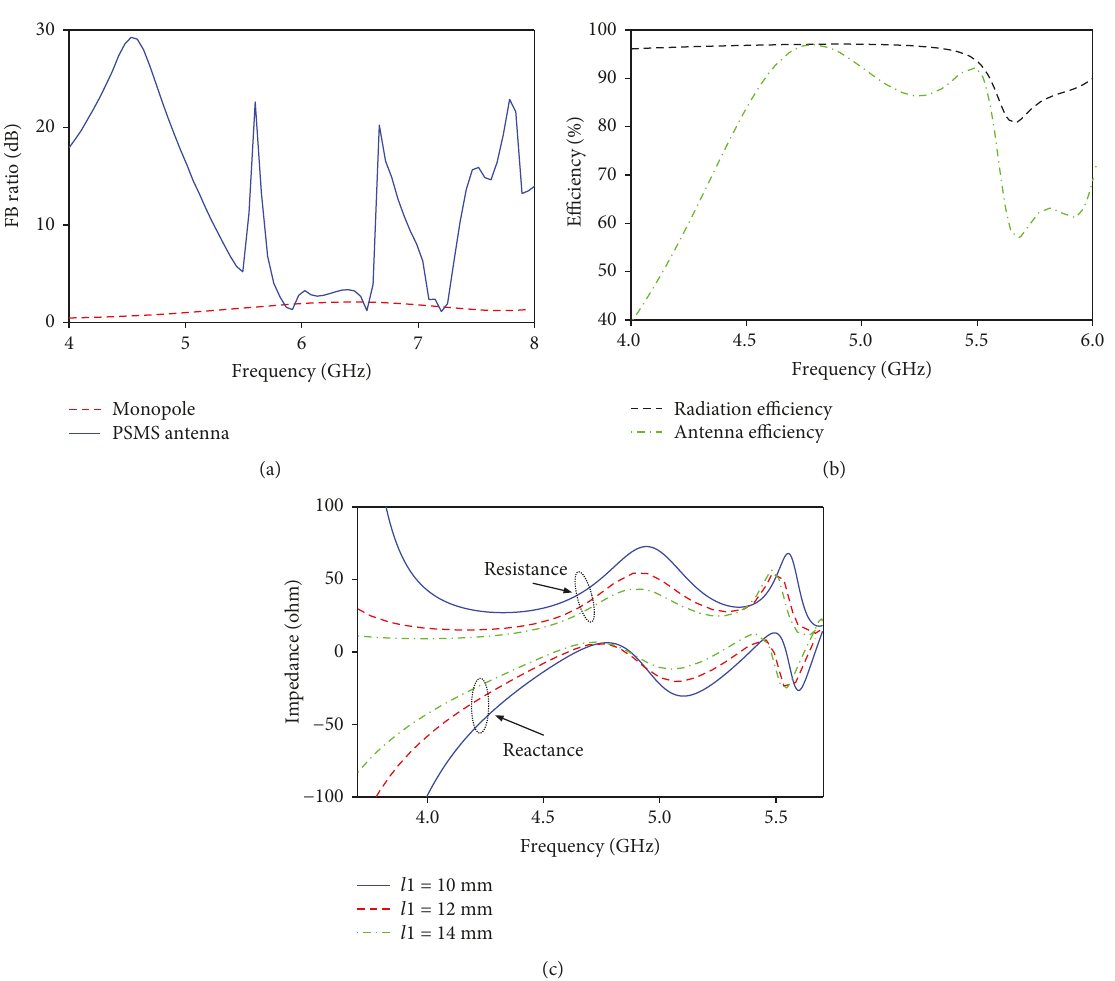
Figure 6: (a) A comparison of FB ratio between the monopole antenna and the PSMS antenna. (b) Simulated radiation e ffi ciency and antenna e ffi ciency of the PSMS antenna. (c) Simulated input impedance of the PSMS antenna with di ff erent microstrip line length l 1 .